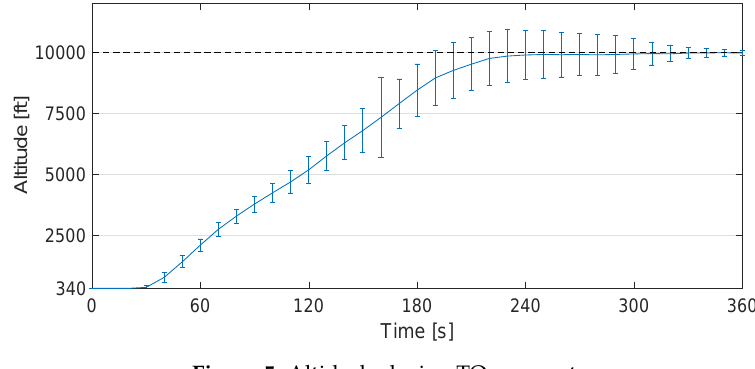
Figure 5. Altidude during TO segment.